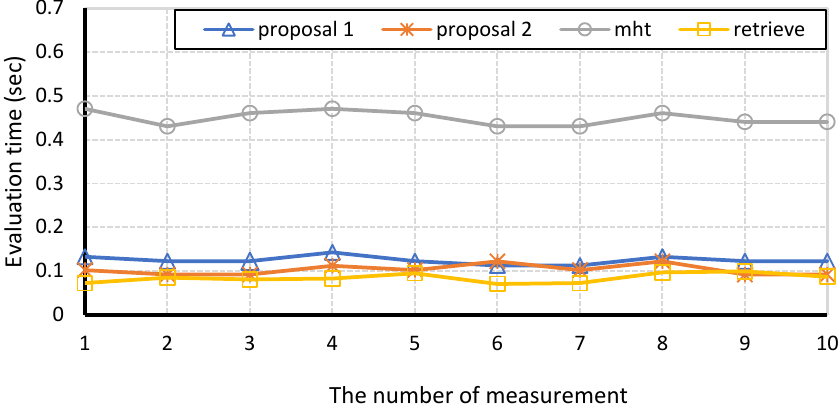
Figure 5. The performance comparisons of the proposed schemes with the computing time of the original MHT and with the downloading content time of NDN.